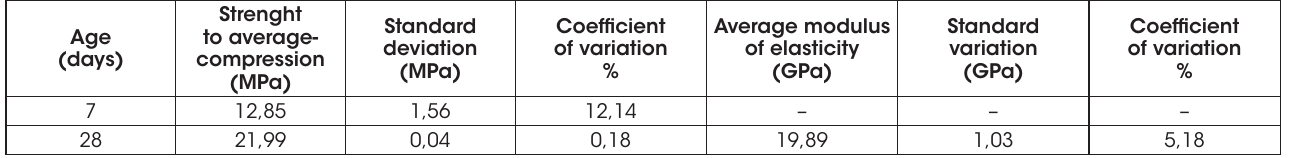
Concrete information for the beams